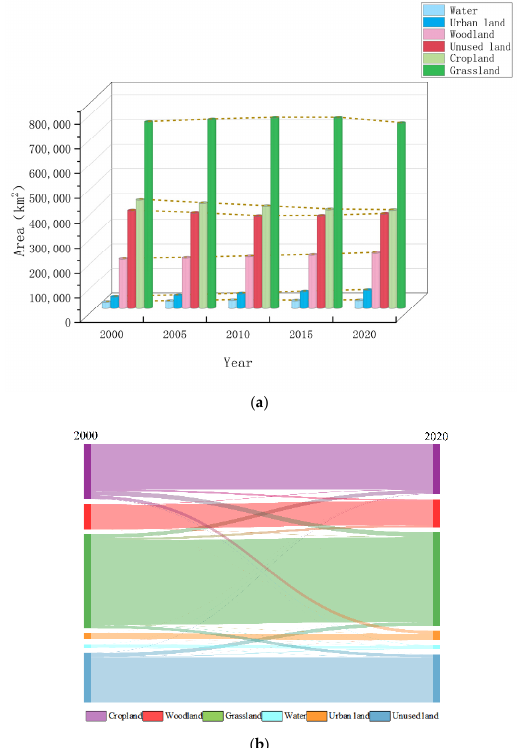
Figure 3. ( a ) Area of each landscape type in the YREEB from 2000 to 2020, ( b ) Transfer matrix of various landscape types from 2000 to 2020 in the YEREEB (unit: km 2 ).